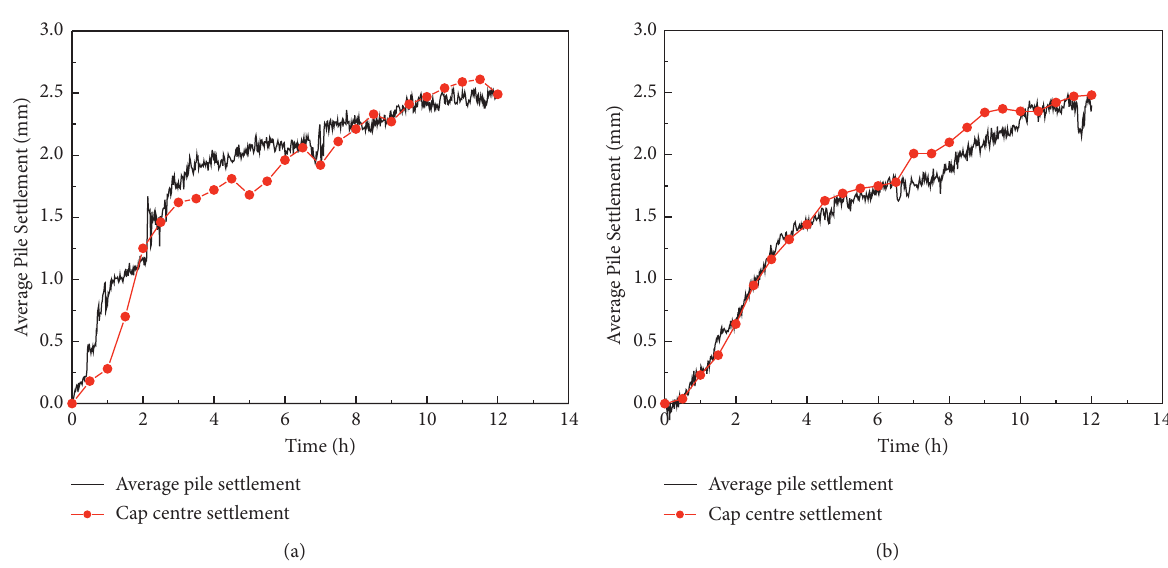
Figure 10: Cap center and pile settlement versus time. (a) Pile load: 12 kN. (b) Pile load: 24